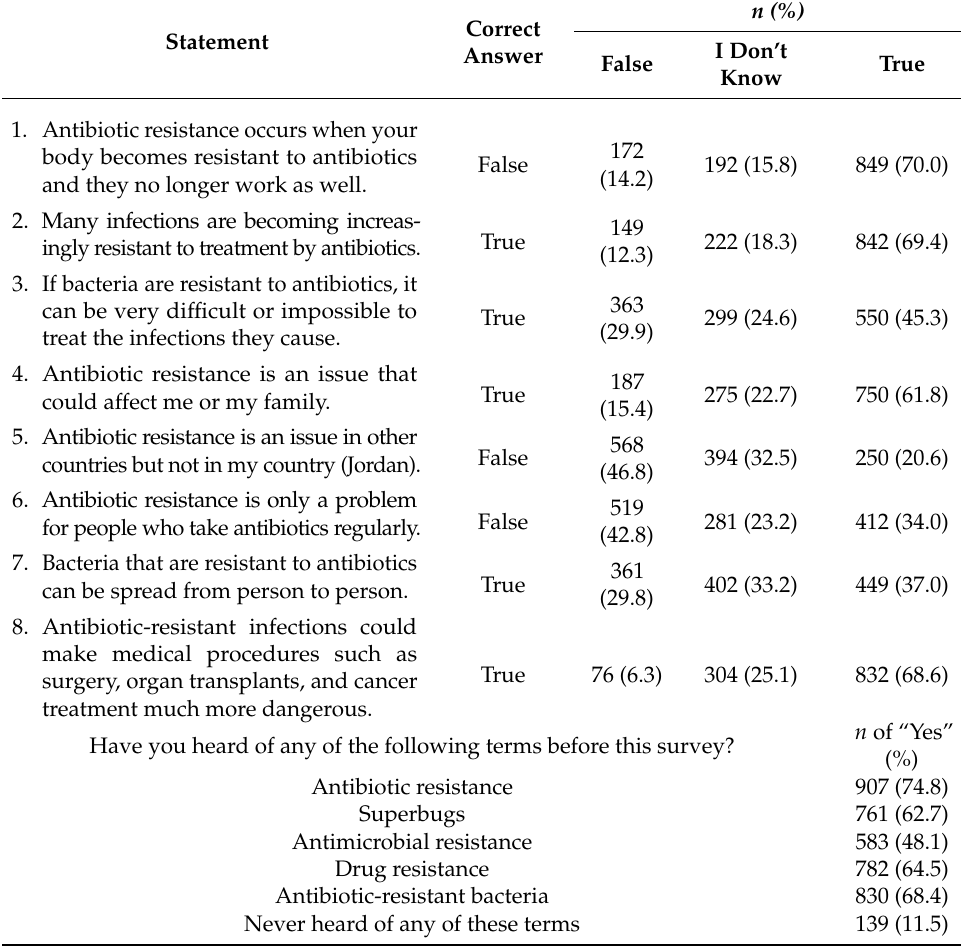
Table 3. Knowledge of antibiotic resistance among